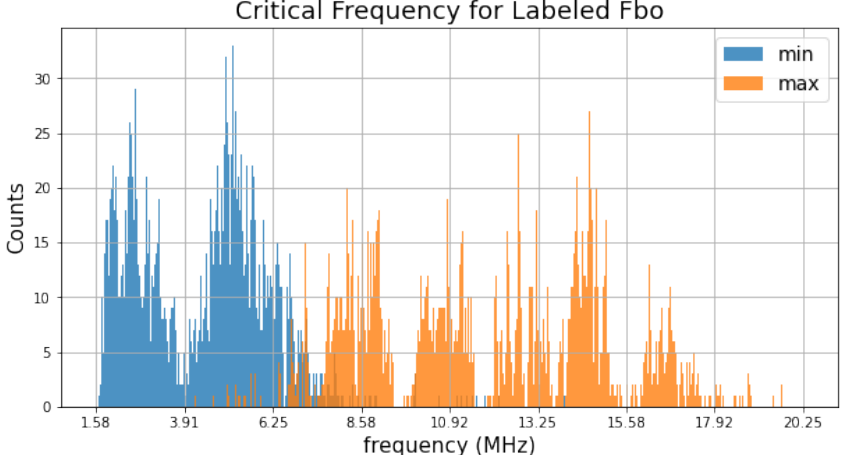
Figure 2. Distributions of the maximum (blue) and minimum (orange) frequencies of the labeled F2 layer of the